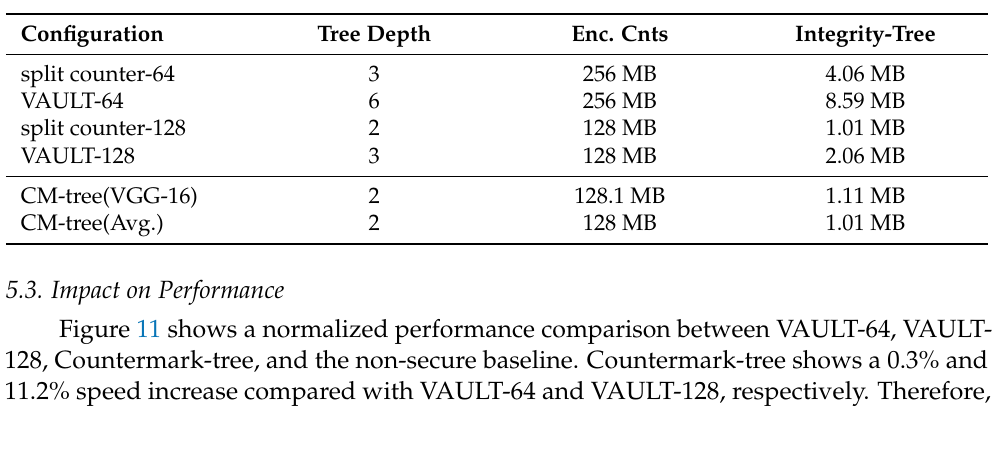
Table 6. Storage overheads for 16 GB